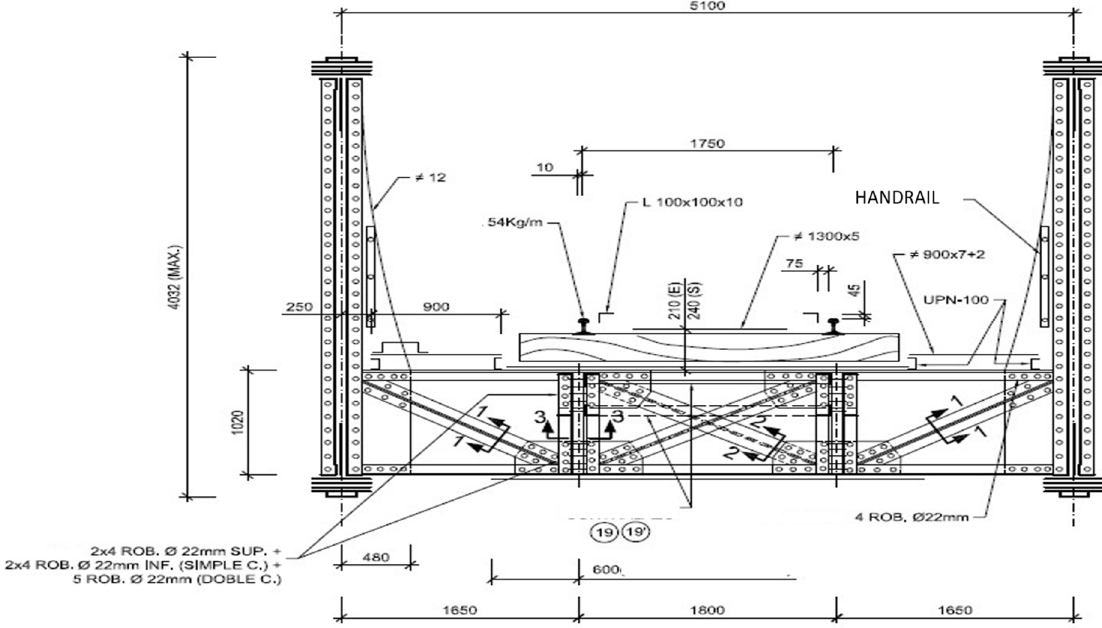
Figure 3. “Arroyo Corbones” transversal section sketch (dimensions in mm).